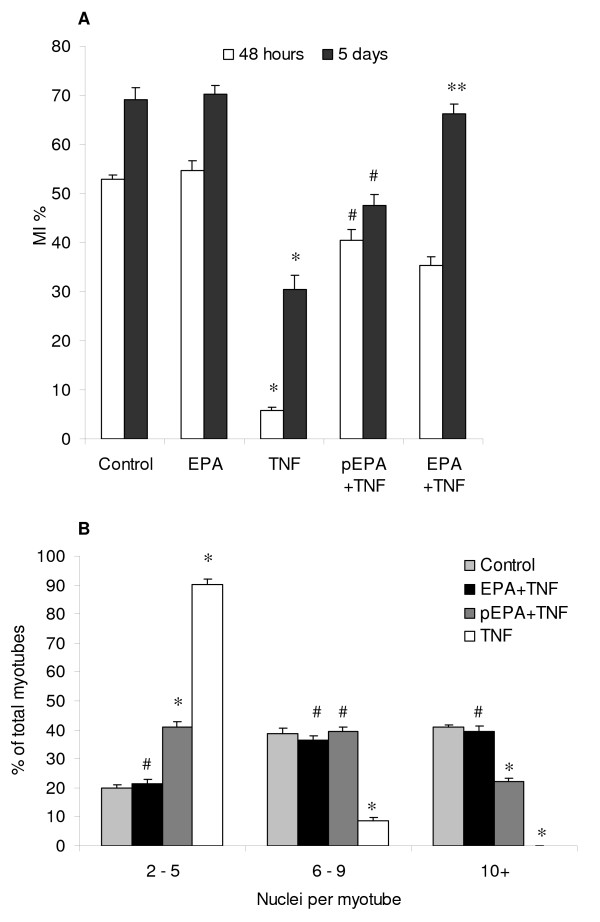
EPA reverses TNF-α-mediated interference with myoblast fusion. C2C12 cells were induced to differentiate in the presence or absence of TNF-α (20 ng/ml) and EPA (50 μM). EPA was added together with TNF-α as a co-treatment (EPA+TNF) or, alternatively EPA was administered alone for a 2 hour pre-treatment after which it was withdrawn and replaced by TNF-α alone in DM (pEPA+TNF). Incubations were continued for 48 hours or 5 days in DM with replenishment of EPA and TNF-α at media changes. A myogenic index (MI) of fusion was calculated from ten images of randomly chosen microscope fields for DAPI and MyHC stained cells from each treatment. The total number of nuclei and the number of nuclei incorporated into myotubes were counted (A). Myotube size heterogeneity was evaluated after 5 days from the same images by calculating the number of nuclei per myotube and classifying them arbitrarily to categories of small (2–5 nuclei), medium (6–9 nuclei) or large (>10 nuclei) myotubes (B). Data are expressed as means ± standard error of mean (SEM) from 3 independent experiments (*p < 0.05 v. respective control; #p < 0.05 v. TNF-α; **NS v. control).